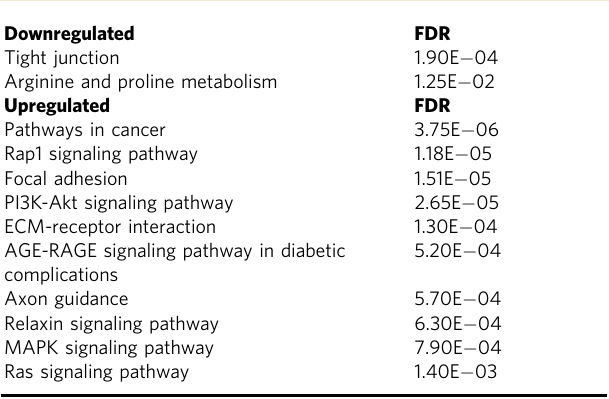
(Supplementary Fig. 8: blue nodes in II), collagens (Supplemen- tary Fig. 8: III), and A Disintegrin and Metalloproteinase with Thrombospondin motifs (ADAMTS) metalloproteases (Supple-